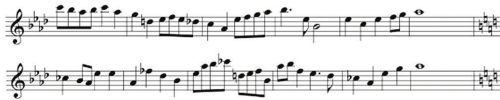
Figure 1: Stimulus examples. Two examples of melodies from the stimulus material; one in Ab-major (top) and one in Ab-minor